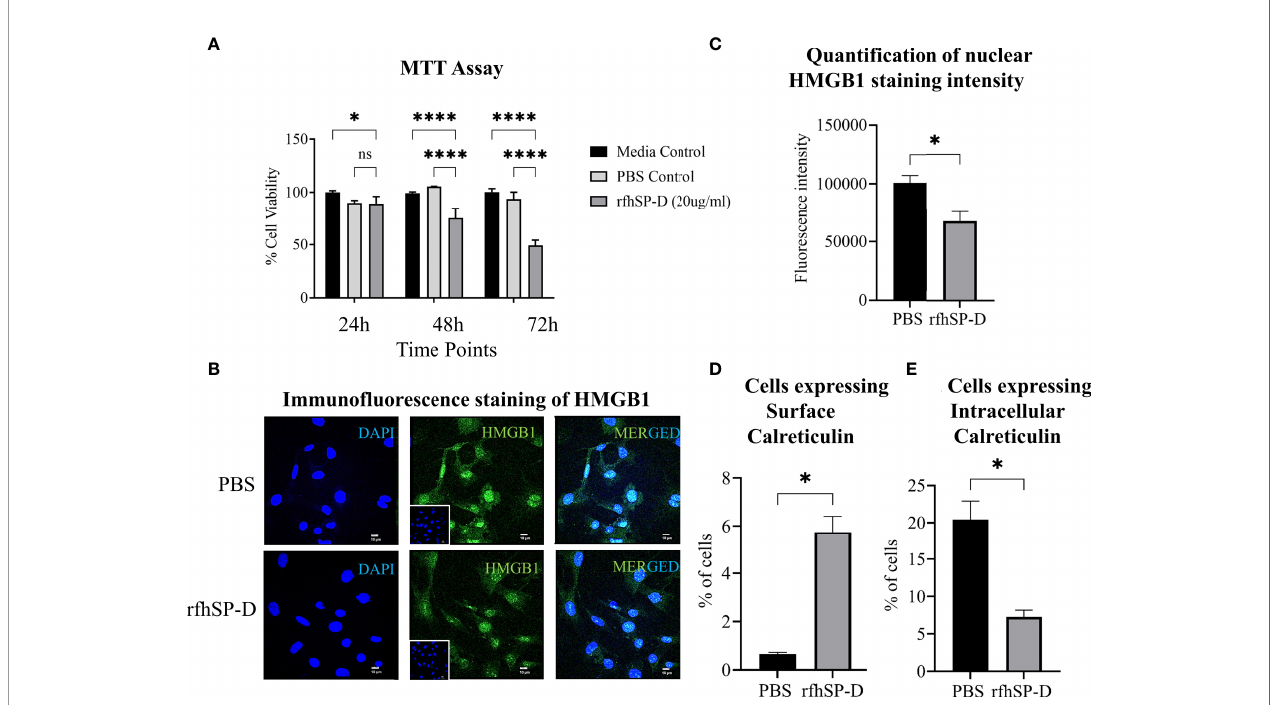
FIGURE 7 | rfhSP-D induces immunogenic cell death (ICD) in TRAMP-C2 cells. (A) TRAMP-C2 cells were incubated in the serum-free media for 12h and then treated with or without rfhSP-D (20µg/ml in PBS). PBS was used as the vehicle control. Treatment was given for the indicated time intervals (24, 48, and 72 h). After treatment, MTT assay was done. Each bar represents % viability ± SEM of three independent experiments relative to the untreated controls or PBS control. After 24h treatment TRAMP C2 cells were analysed by immuno fl uorescence or fl ow cytometry. (B) Representative images showing immuno fl uorescence staining of nuclear high mobility group box protein 1 (HMGB1) (Green) and DAPI (Blue) (C) Quanti fi cation of nuclear HMGB1 staining intensity using ImageJ. (D) Flow cytometric analysis of cell-surface exposed calreticulin (CRT) in the non-permealized cells; and (E) intra-cellular calrticulin in permealized cells. Samples were analyzed in triplicate and represented as mean ± SEM. Statistical signi fi cance was determined by two-way ANOVA (A) , two-tailed Student ’ s t-test (B – E) . ns, Non-signi fi cant. *p < 0.05, ****p < 0.0001.